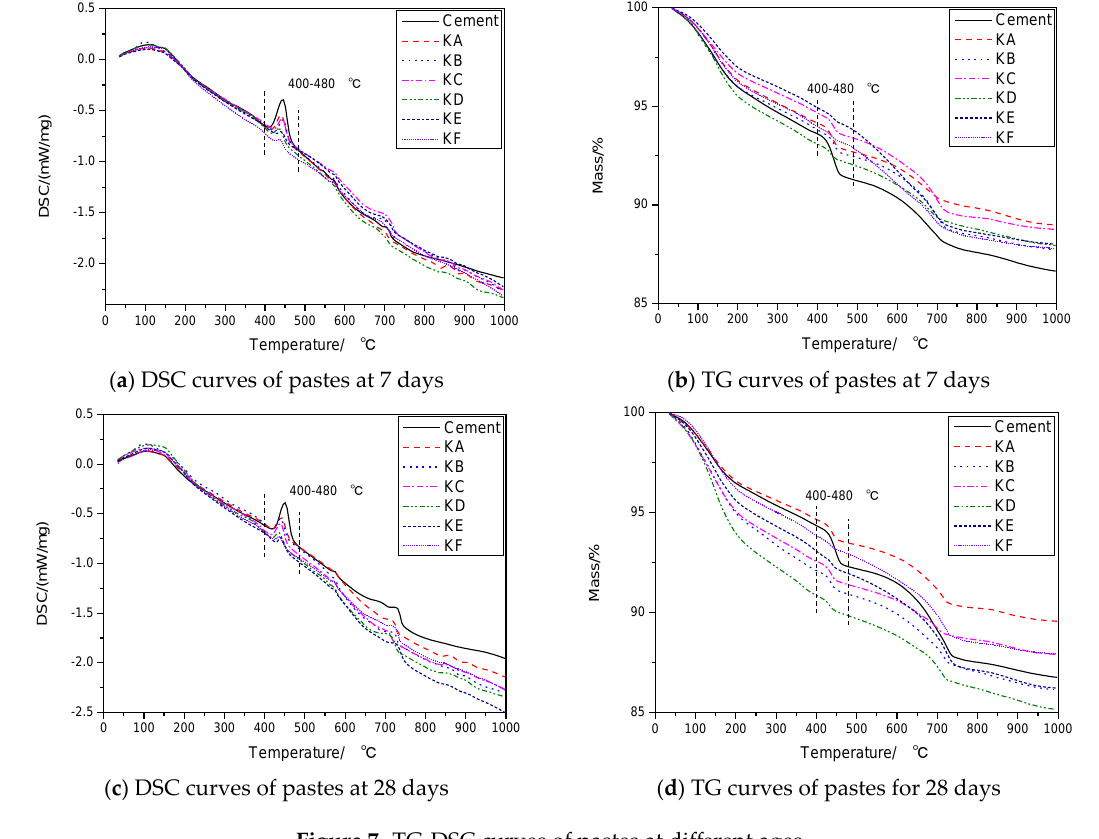
Figure 7. TG-DSC curves of pastes at different ages. Table 4. Ca(OH) 2 content of pastes at different ages,%.